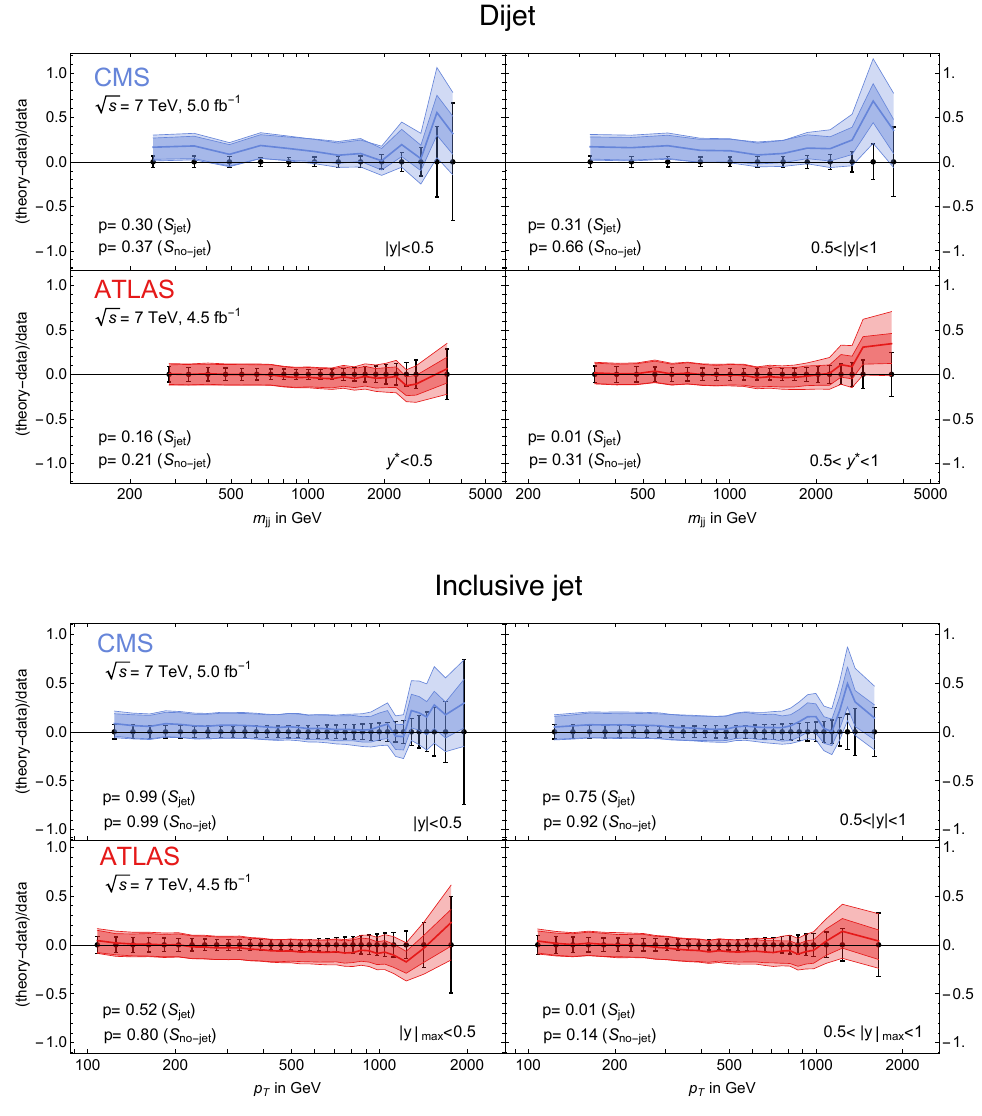
Figure 2 . Comparison of our theory predictions with the experimental data. We show the re- sults for the two most central rapidity bins of each analysis. The black error bars represent the experimental uncertainties. The shaded regions represent the sum in quadrature of all theory un- certainties. The lighter shaded regions correspond to S nojet while the darker one to S jet . The theory prediction is the thick colored line. For each bin we show the p-value that results from eq. (2.2).